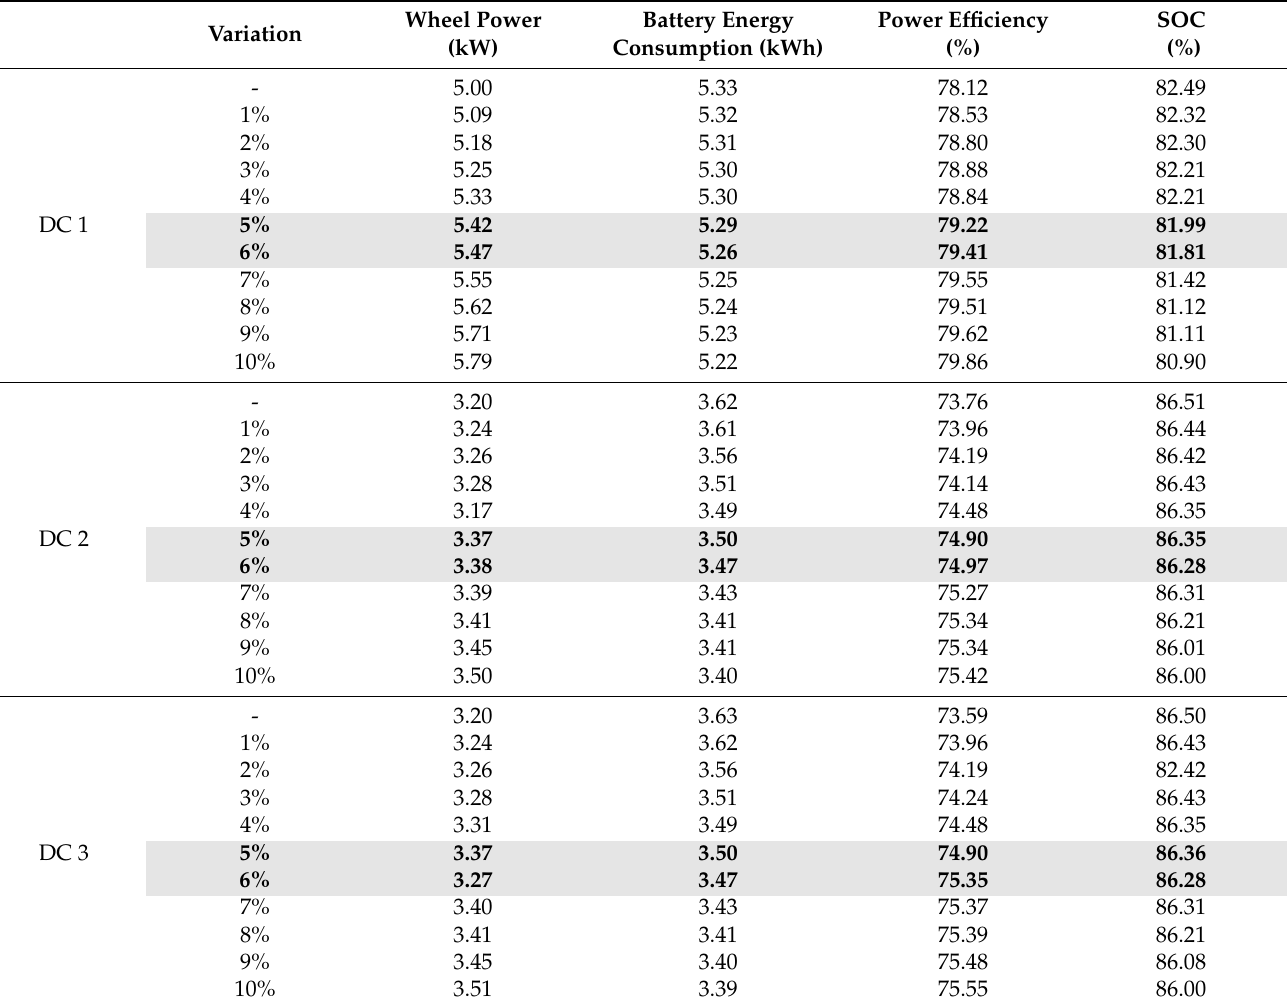
Table 4. Results of energy efficiency in EV applying the driver cycle optimizer in 3 tests with different variations in the reference speed. It is highlighted that the most significant increase in efficiency occurs when the variation δ is between 5% and